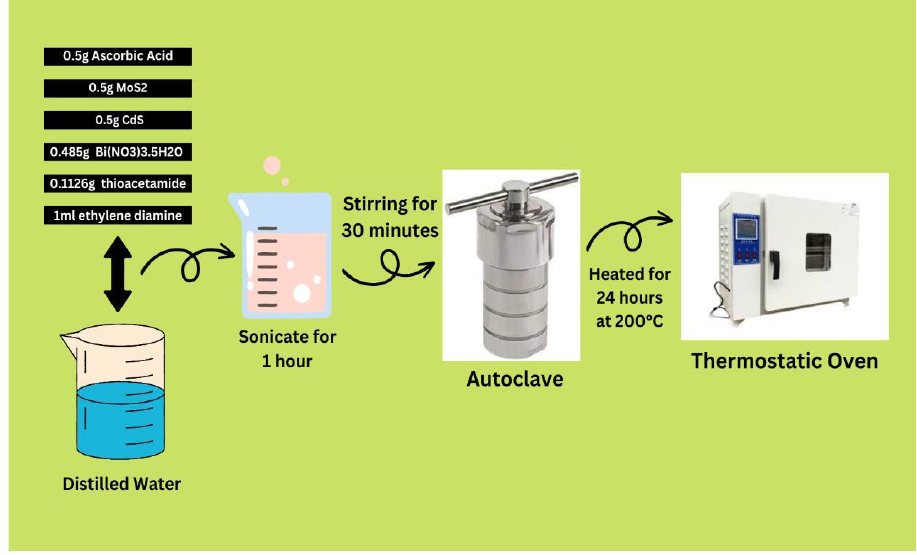
Figure 12. Synthesis of CdS/MoS 2 /Bi 2 S 3 composites.